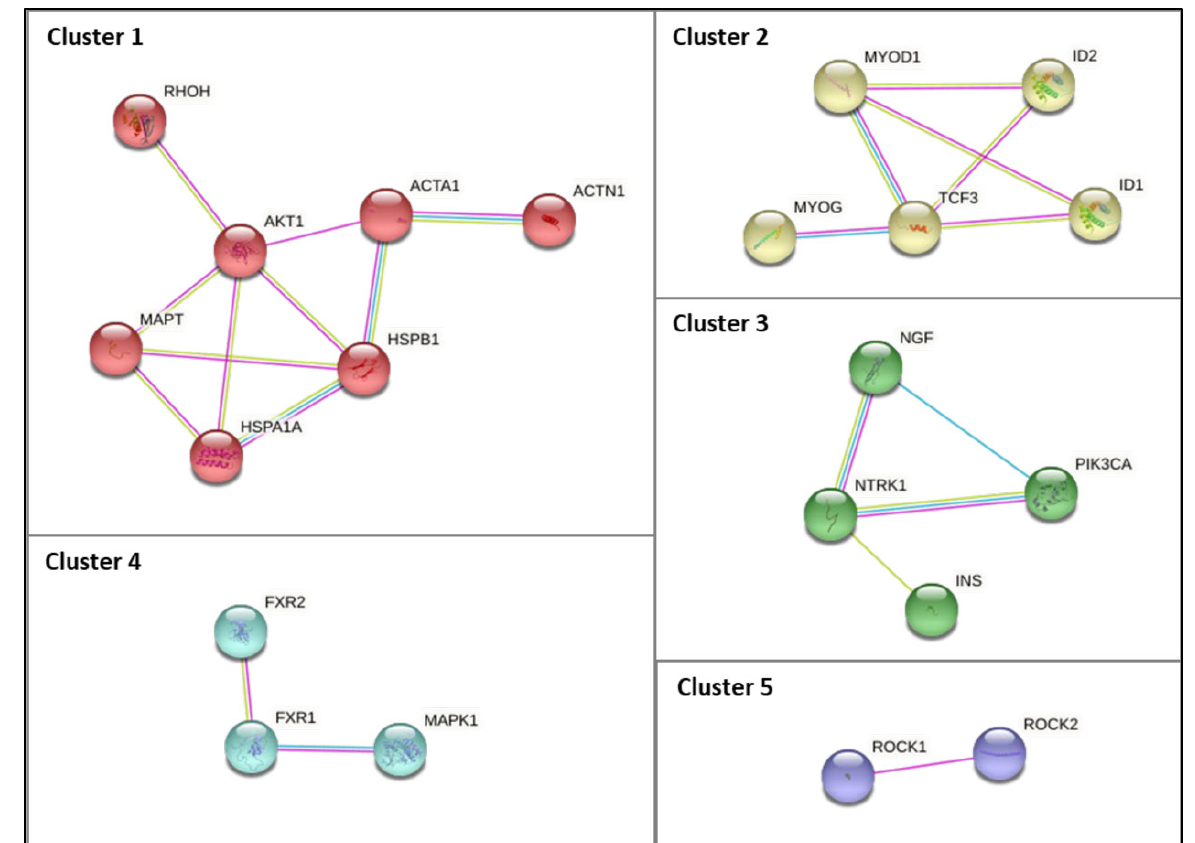
Figure 6. PPI subnetworks of clusters (1 to 5) comprising the genes identified in VOSviewer analysis associated with GO biological processes related to protein metabolism. The PPI subnetwork was constructed using the STRING database by applying the Markov clustering (MCL) algorithm (inflation parameter of 1.8). The edges indicate that the directly linked proteins are part of the same physical complex, although in large complexes, this may not signify that they are directly bound to each other. The edge color denotes the interaction source; blue edges denote known interactions from curated databases, pink edges denote experimentally determined known interactions, and green edges denote interactions inferred by text mining.